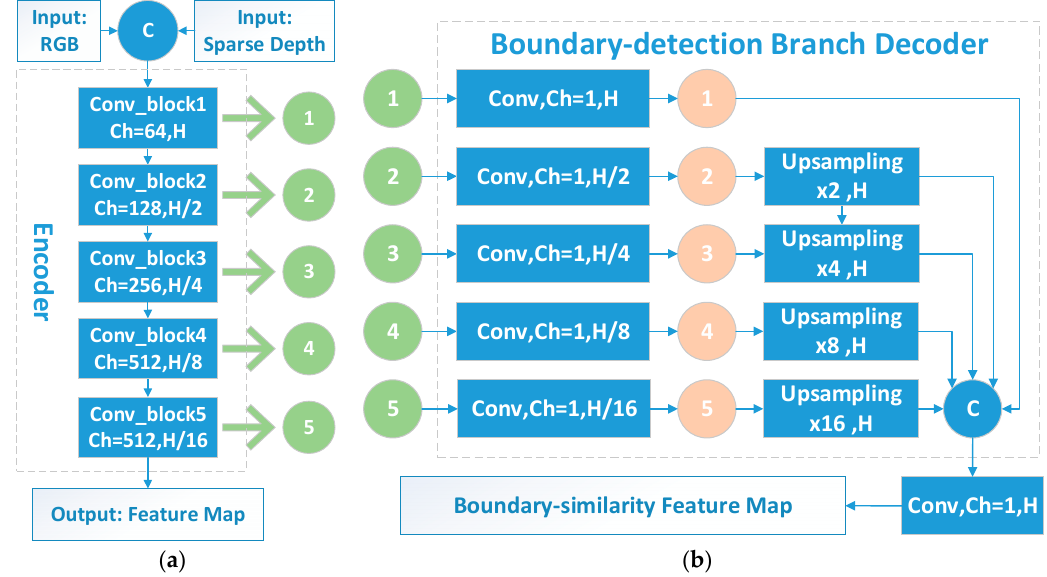
Figure 2. Proposed feature-sharing encoder ( a ) and boundary-detection decoder ( b ). Blue node C refers to the concatenate layer. The green and pink node with the number i represent the skipped and the boundary similarity feature from the i th scale, respectively. H represents the raw resolution of the input image and H /2 i − 1 refers to the resolution after the i th pooling. Ch = m represents the output channel number m for each Conv_Block. The bilinear interpolation upsampling layer in ( b ) is denoted as Upsampling × 2 i − 1 , where 2 i − 1 represents the upsampling ratio.